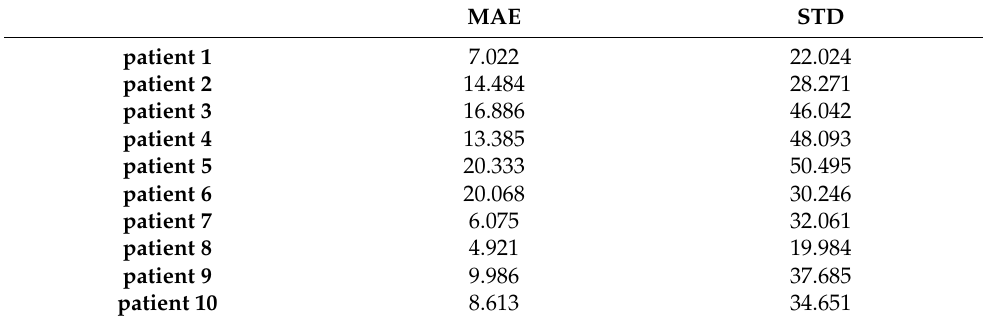
Figure 4. Program view of the central pair angles measured and visualized in the analyzed image with points visibility set to 0 (invisible). The base level of 0 angle is X axis represented by blue angle line. The yellow lines represent the orientation deviation from base level. Individual angle values are shown in the right panel listing angles and offsets from the mean. Table 3. Statistics for angles: Mean absolute error (MAE) and its standard deviation (STD) for evaluated 10 patients comparing the automatically measured angle values against manual corrections.